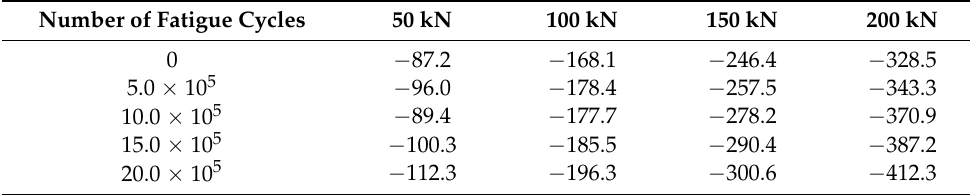
Table 7. Table of mid-span tensile strain variation with fatigue times after freeze–thaw damage of test plate strengthened with bonded steel plate ( με ). Table 8. Table of mid-span compressive strain variation with fatigue times after freeze–thaw damage of test plate strengthened with bonded steel plate ( µε ).